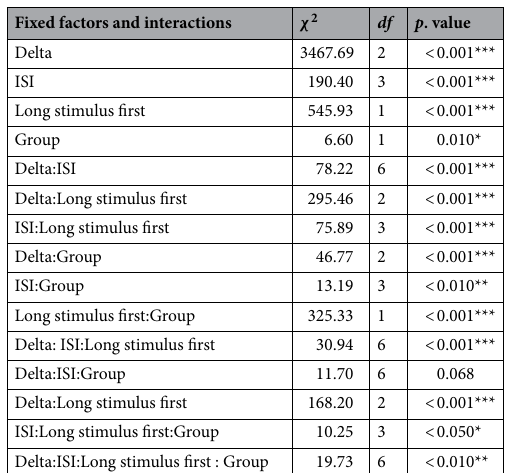
2 Table 2. Statistical table. Results of the II Wald χ test on the best model explaining accuracy. All fixed factors and their interaction term, except for the Delta × ISI × Group interaction, were statistically significant. (Significant codes: ***, p -value < 0.001; **, a p -value < 0.01; and *, a p -value < 0.05).